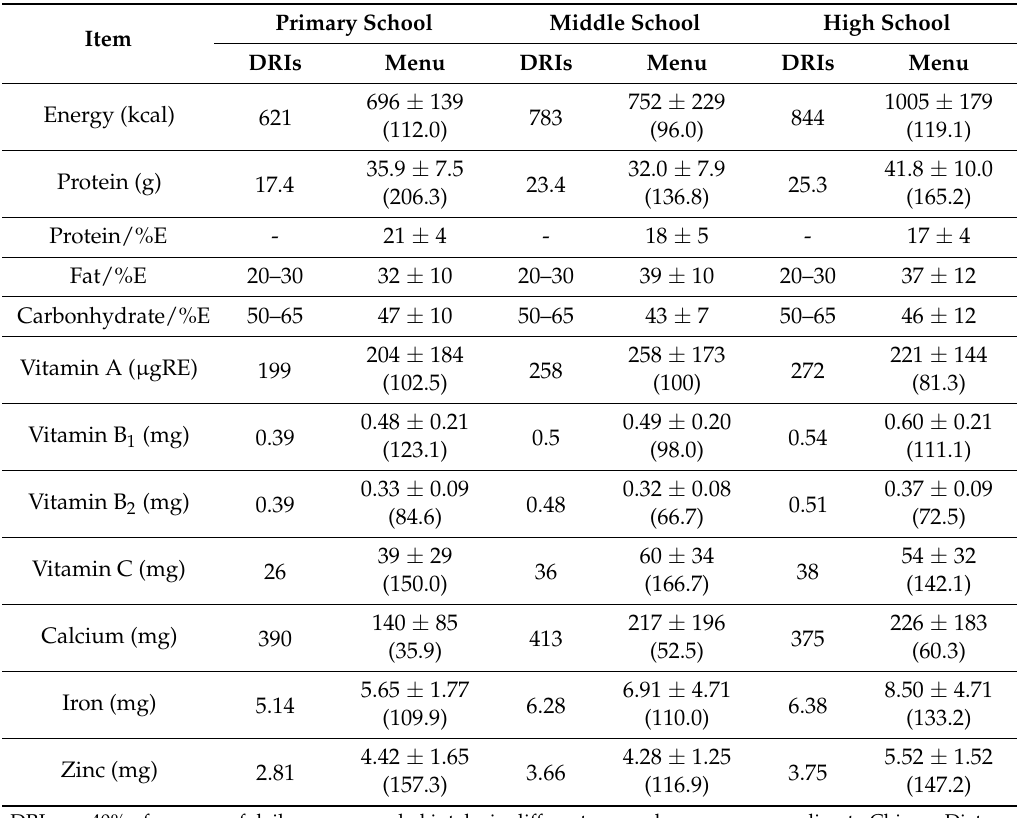
Table 2. Provision of energy and nutrients in 20 schools as compared to DRIs-2013/ n